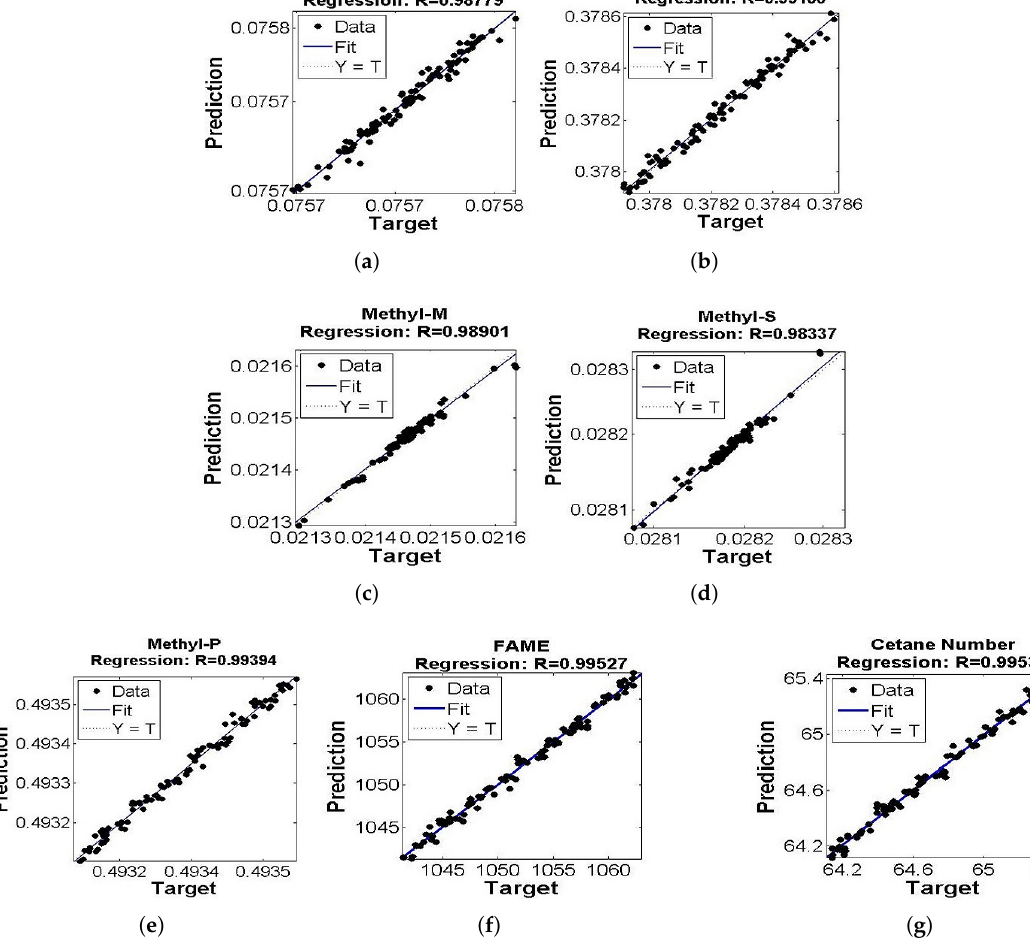
Figure 5. ( a – g ) Regression performance of ensemble model of Methyl-Li, Methyl-O, Methyl-M, Methyl-S, Methyl-P, Fame and Cetane